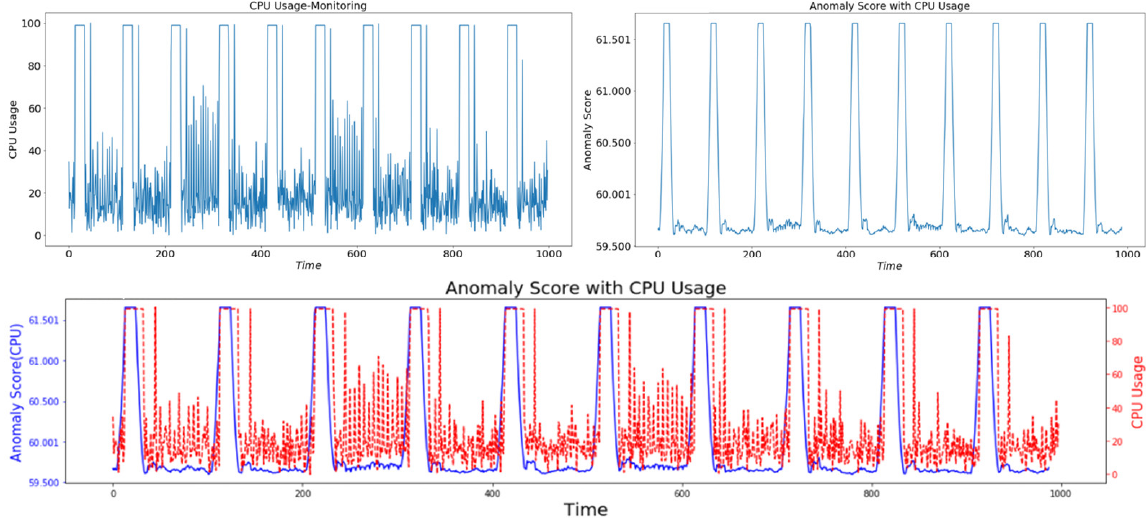
Figure 5. Anomaly Score (CPU Fault).